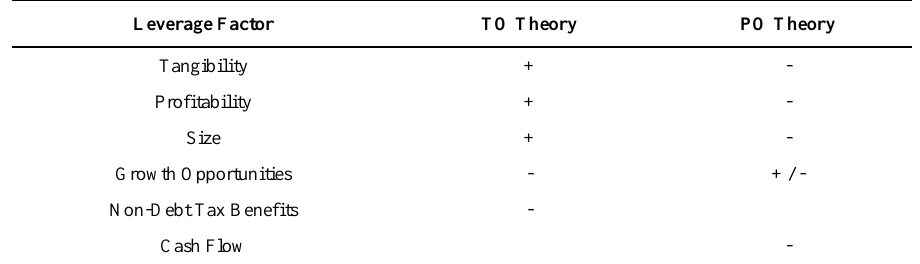
Table 2. Expected relationship by TOT and POT between indebtedness and determinants of capital structure.